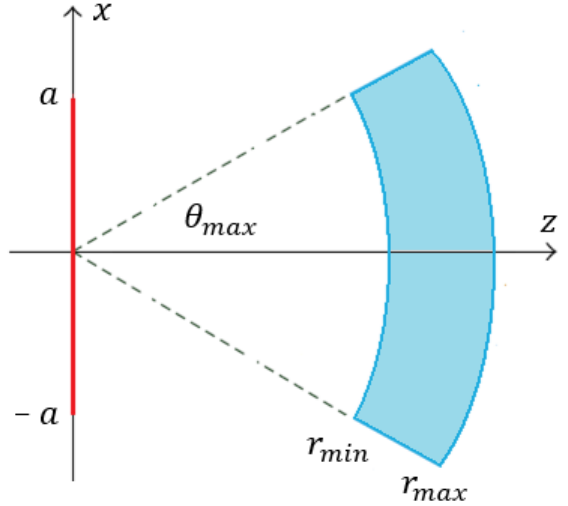
Figure 1. Geometry of the